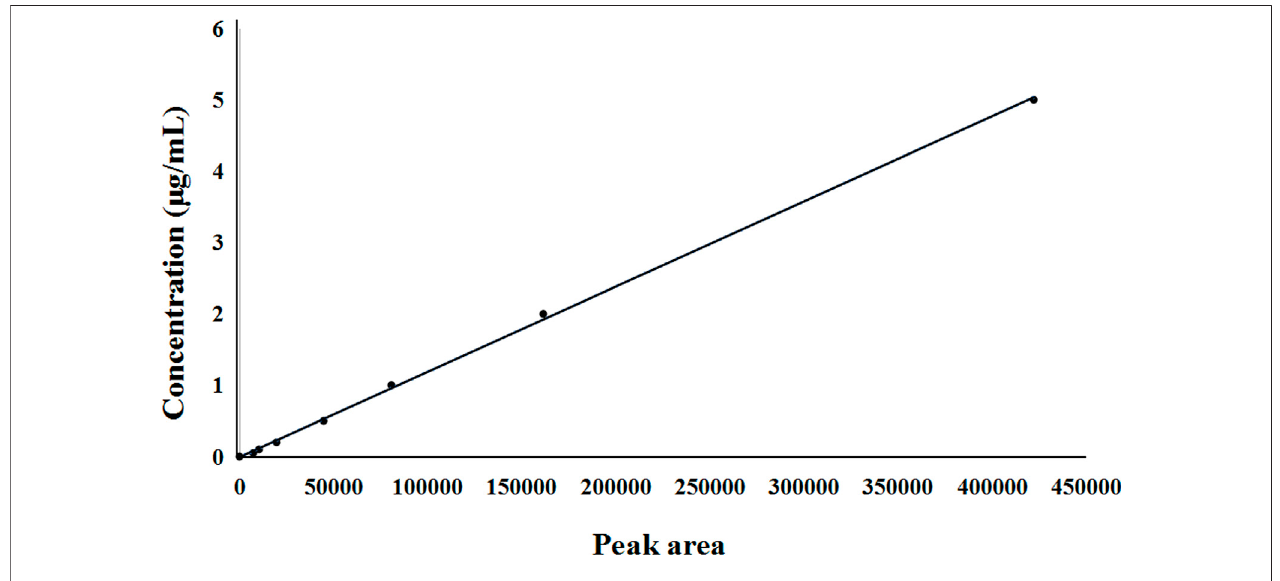
FIGURE 2 | Standard curve of anwulignan in plasma.